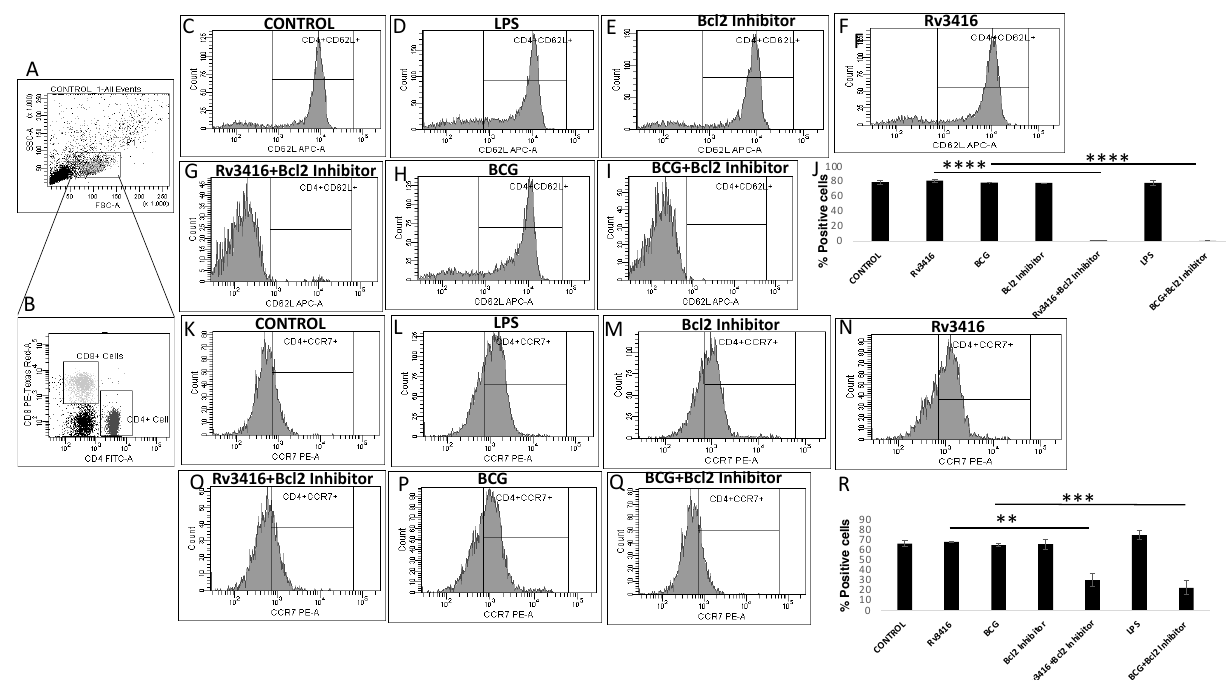
Figure 9: Bcl2 inhibited Rv3416 stimulated PBMCs induces effector phenotype in CD4+T cells. PBMCs enriched from blood of healthy volunteers were treated with 10μM Bcl2 inhibitor (Panels E,G,I,M,O,Q) or LPS (Panels D&L) for 1h followed by stimulation with 15 μg/ml Rv3416 (Panels F,G,N,O) or infection with BCG 2.5 MOI (Panels H,I,P&Q) for 48h. Cells were processed for flow cytometry on BD-FACS Aria III. Panel A shows the lymphocyte population gated on FSC and SSC. Panel B shows the CD4 + (FITC) and CD8 + T (PE-Texas-Red) cells from the gated population in Panel A. CD4 + T cells were stained either with APC conjugated CD62L (Panel C-I) and PE conjugated CCR7 specific monoclonal antibodies (Panel K-Q). The data were plotted and analyzed using BD-FACS Diva Software version 6.1.3 (BD Biosciences, USA). Y axis in Panels C to I and Panels K to Q represent counts as plotted by the flow cytometer. Y axis in Panels J&R represent percent positive cells within the marker in each histogram as calculated by the flow cytometer. Bar charts in Panels J&R represent Mean Fluorescence Intensities (MFI) of Panel C-I and Panel K-Q, respectively. Data shows a representative image of two experiments. Data represents Mean ± SD of two independent experiments. In Panel J, P value between groups Rv3416 and Rv3416+Bcl2 Inhibitor is P<0.0001 and between groups BCG and BCG+Bcl2 Inhibitor is P<0.0001. In Panel R, P value between groups Rv3416 and Rv3416+Bcl2 Inhibitor is P<0.01 and between groups BCG and BCG+Bcl2 Inhibitor is P<0.001. One way ANOVA was performed followed by Bonferroni’s multiple comparison post-hoc test with 95% confidence interval. ** denotes statistical significance at P<0.01. *** denotes statistical significance at P<0.001. **** denotes statistical significance at